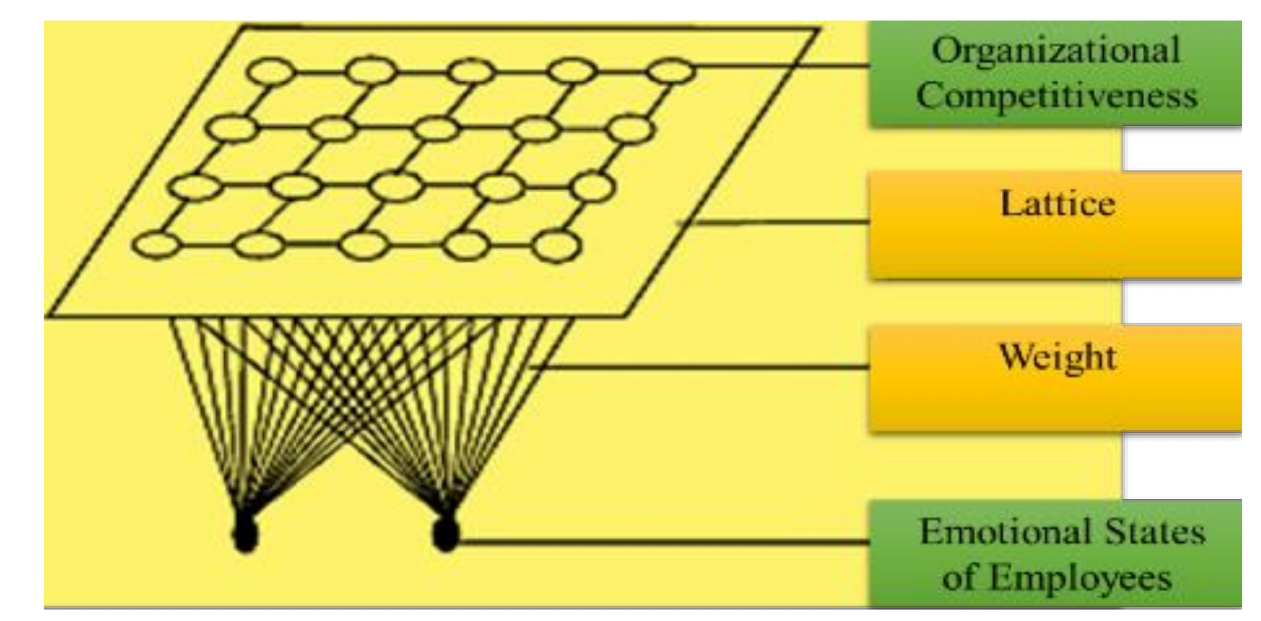
Figure 5. Self-organizing map with input and output